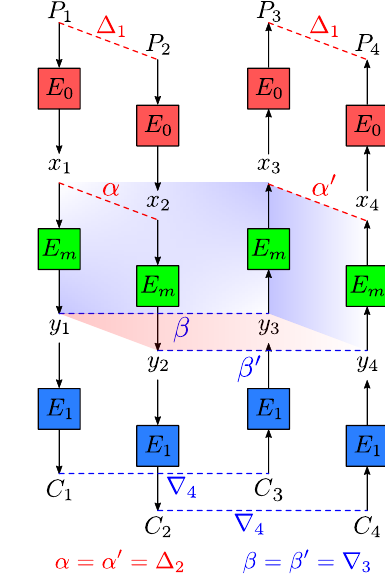
Figure 1: Basic boomerang attack (left) and Sandwich attack